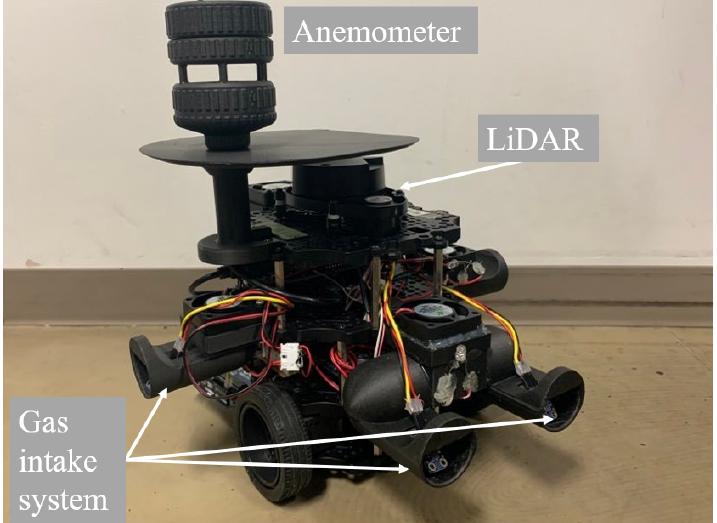
Figure 14. Bombyxbot3, our designed olfactory robot.